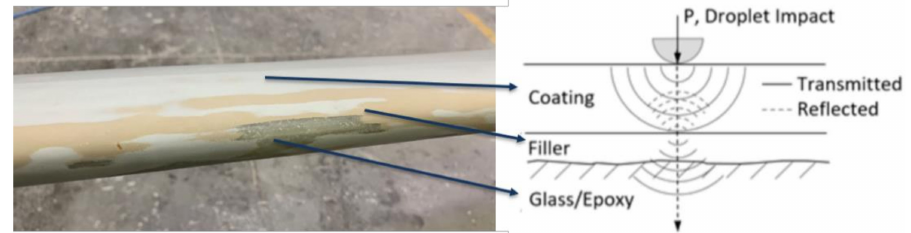
Figure 21. Blade section in reparation showing di ff erent areas with di ff erent substrates. Droplet impact reflected / transmitted stress on interface due to relative